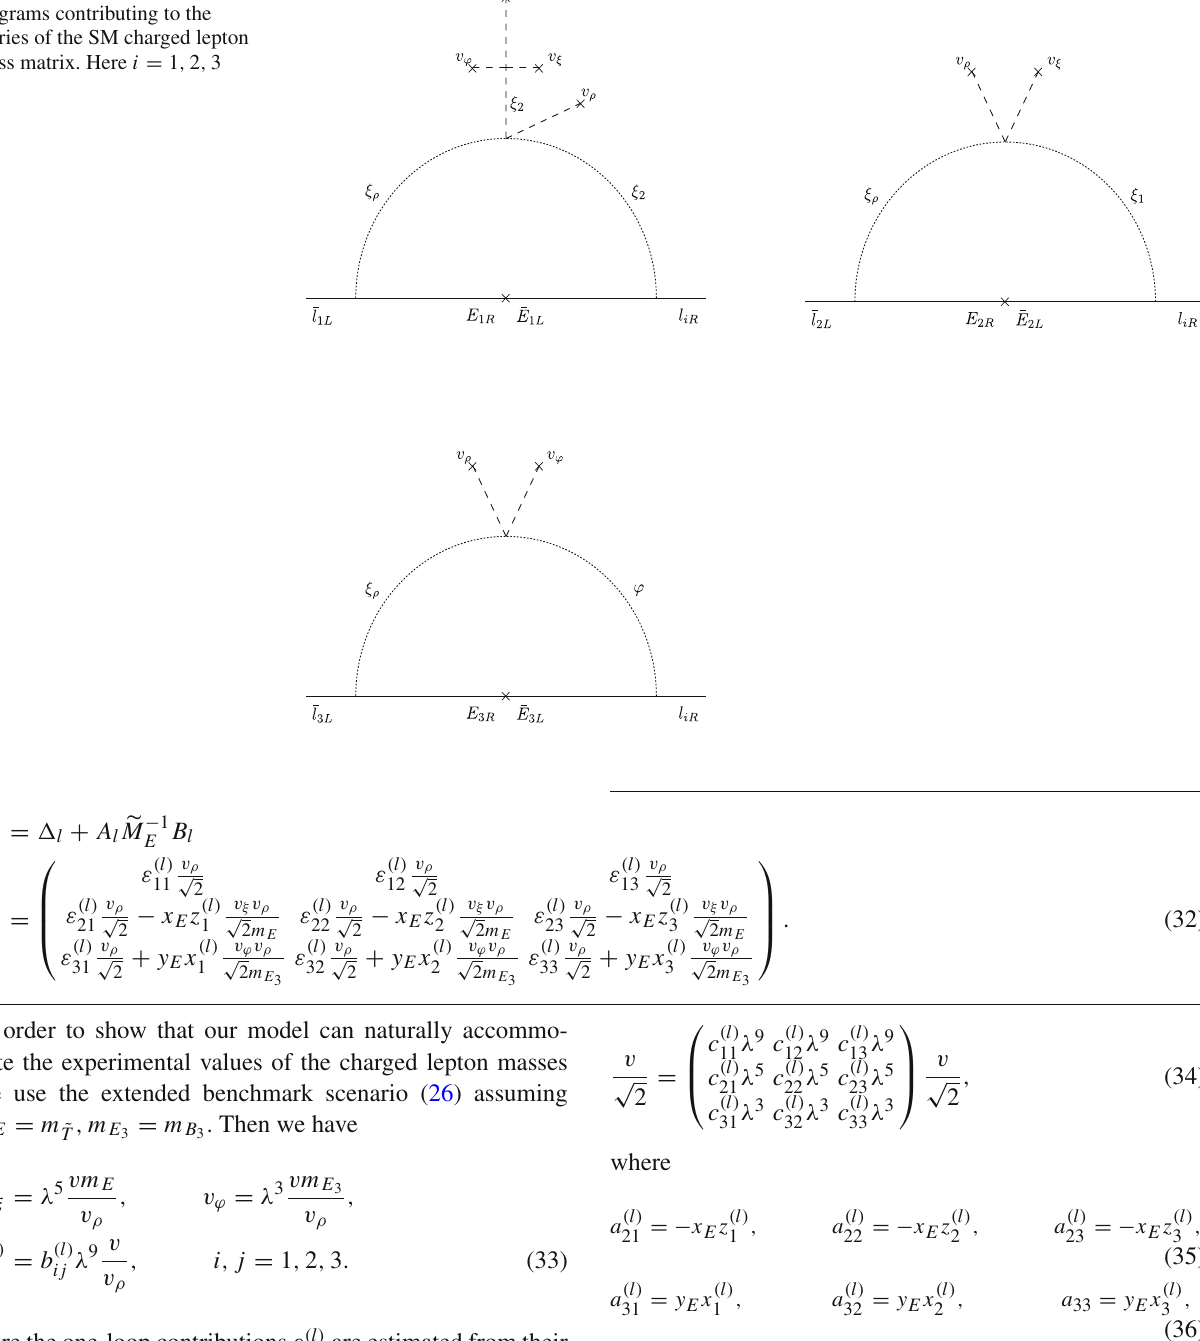
Fig. 4 One-loop Feynman diagrams contributing to the entries of the SM charged lepton mass matrix. Here i = 1 , 2 ,